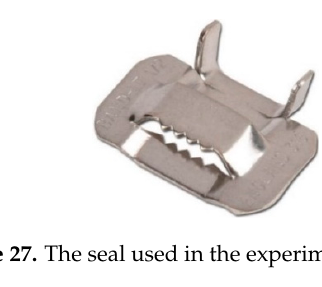
Figure 27. The seal used in the experimental program.